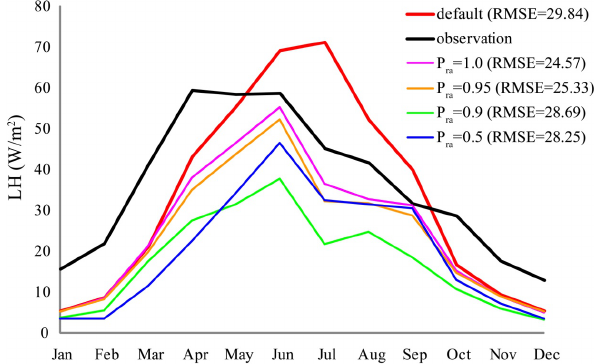
Figure 6. Simulated heat fluxes using the posterior estimates of parameters with daily 813 Fig. 6. Simulated heat fluxes using the posterior estimates of param- observations at the US-ARM site. 814 eters with daily observations at the US-ARM